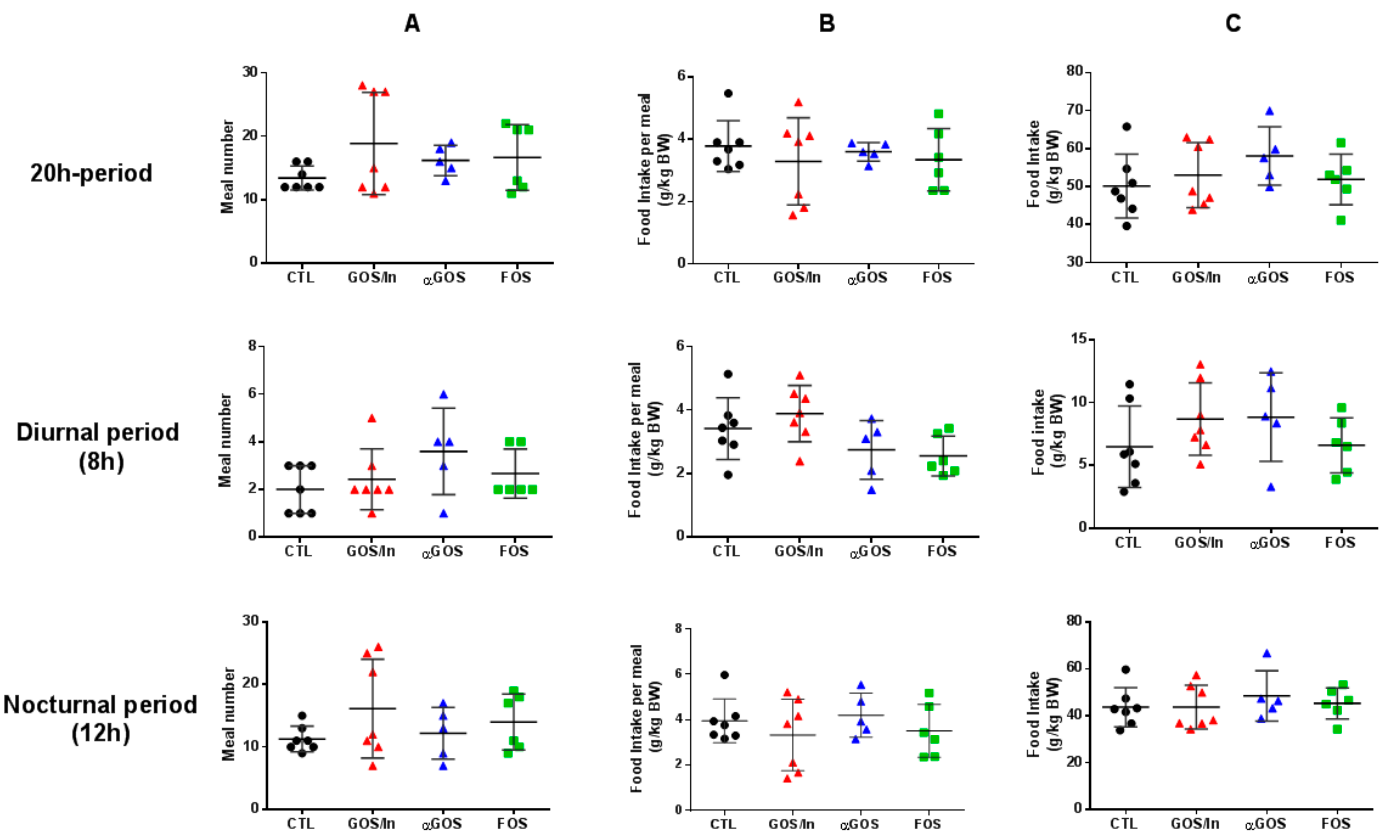
Figure 9. Feeding patterns illustrated by ( A ) Meal number; ( B ) Food intake per meal; ( C ) Food intake during the considered period analyzed in physiological cages at PND 75–100 ( n = 5–7 per group). BW, bodyweight. Individuals, means and SD are plotted ( n = 5 to 7 per groups).